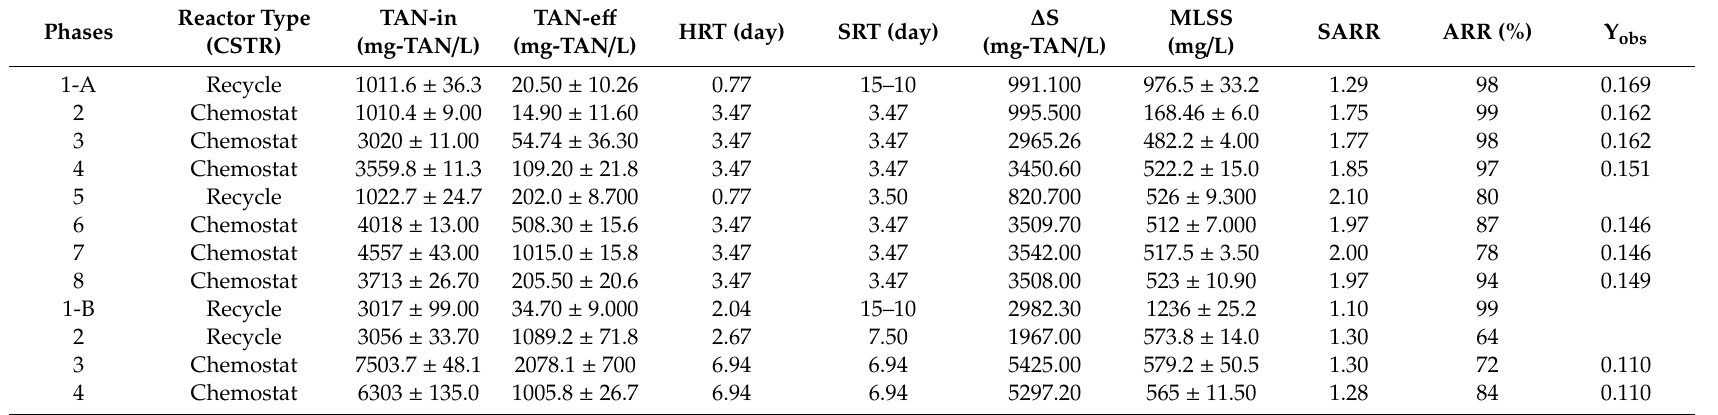
Table 2. Total ammonium nitrogen (TAN) influent and e ffl uent, ∆ S, HRT, SRT, MLSS, SOUR, and ARR e ffi ciency in each phase. Y obs estimated from daily profile data when the reactor was in Chemostat